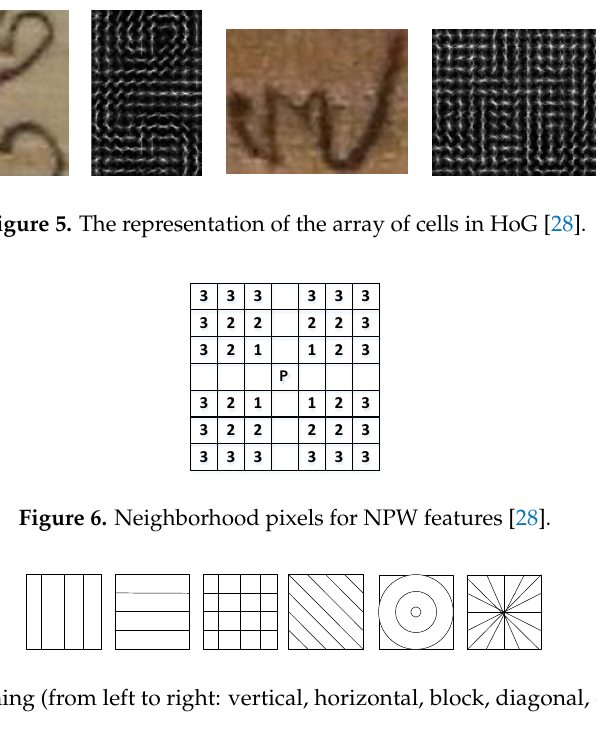
Figure 8. Scheme of NPW on Kirsch features [28].